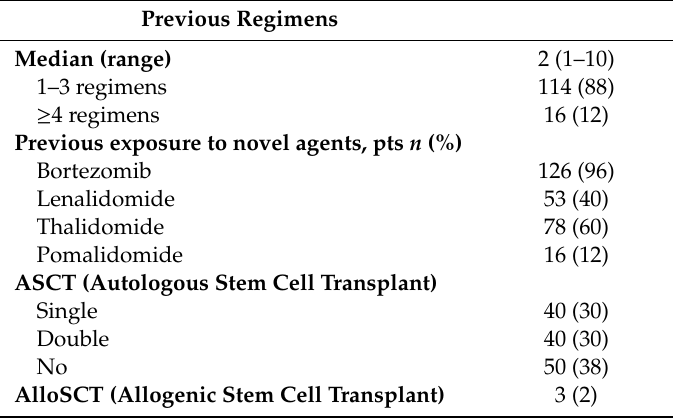
Table 2. Prior regimens used of 130 relapse and refractory multiple myeloma (RRMM) candidates to KRd as salvage regimen in a real-life